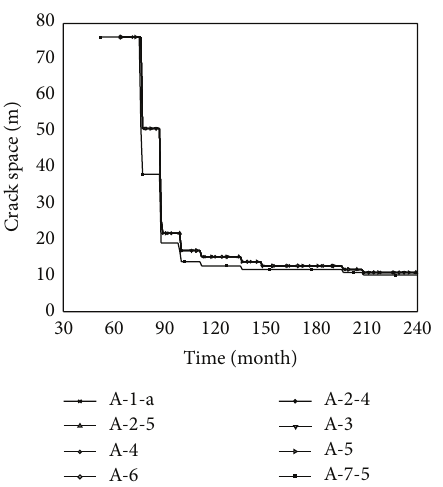
Figure 6: Influence of subgrade type on thermal cracking space on asphalt pavement.